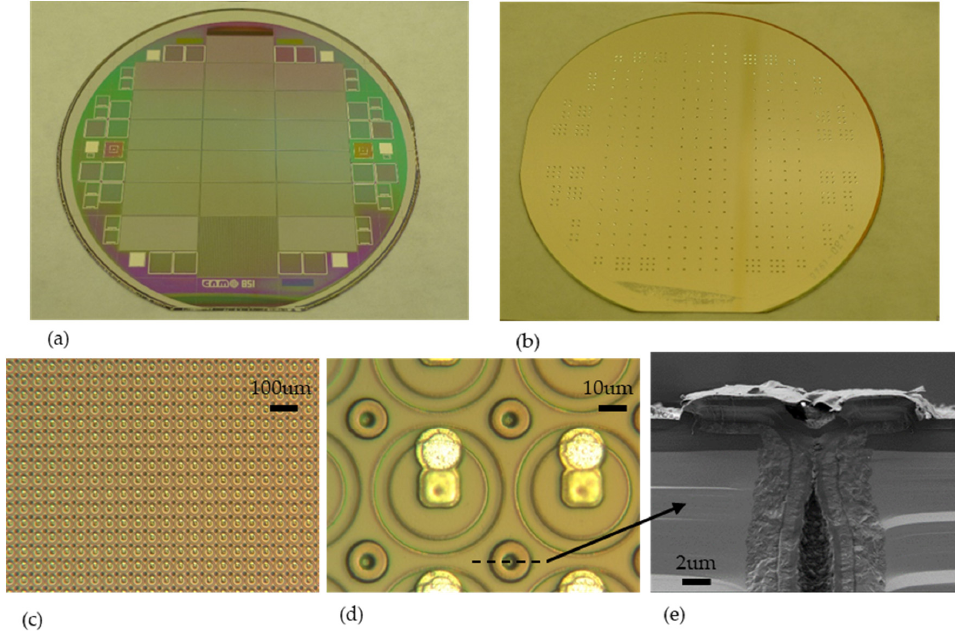
Figure 15. Front side ( a ) and backside ( b ) photographs of single-side SOI wafers. Pads from p+ electrodes are visible on the front side. View of RD53A 50 × 50 µ m 2 devices ( c , d ) and Scanning Electron Microscope (SEM) cross-section of p+ pad ( e ).